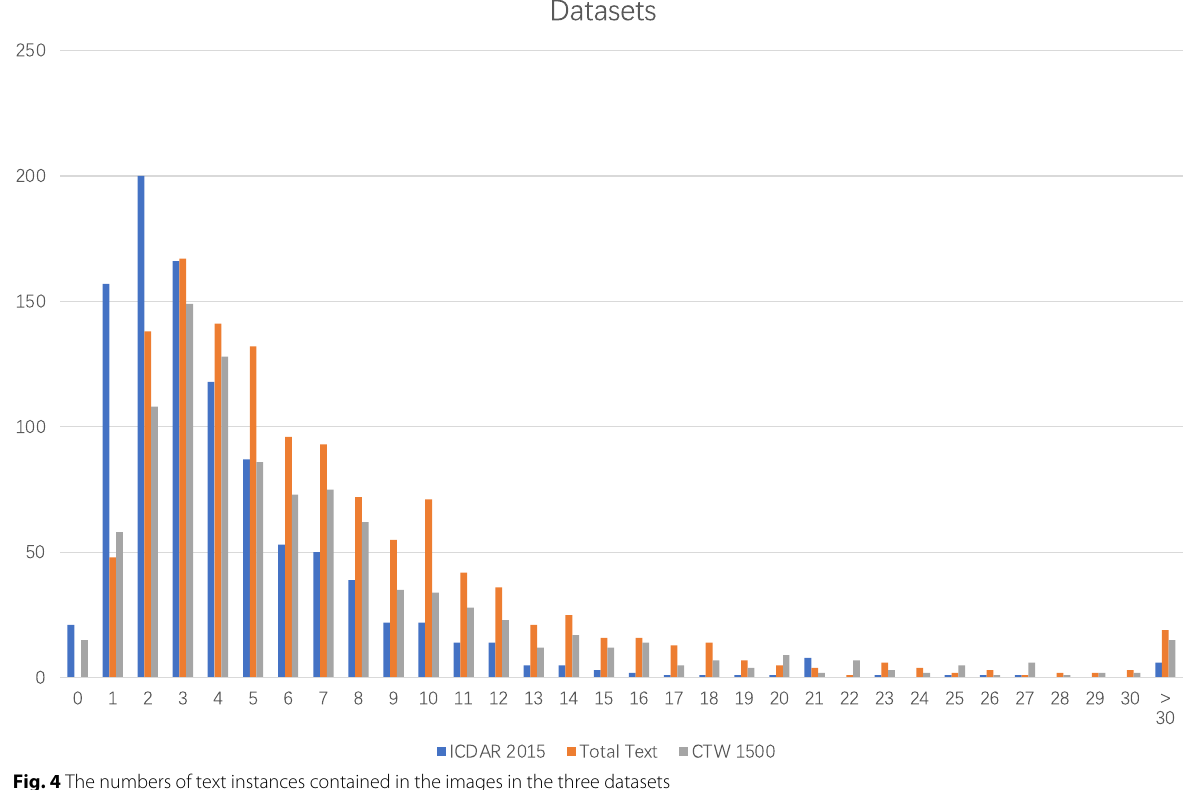
In the end-to-end task, the prediction is considered as a true positive only if the detection matched and predicted transcription is identical to the corresponding ground- truth. For a fair comparison, images of MLT2017 are not used for training, following settings in Lyu et al.